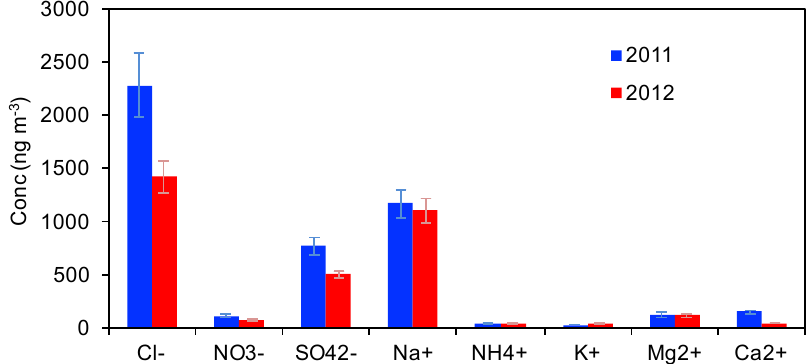
Figure 4. Average concentration values of inorganic ions detected both during AREX2011 and AREX2012.